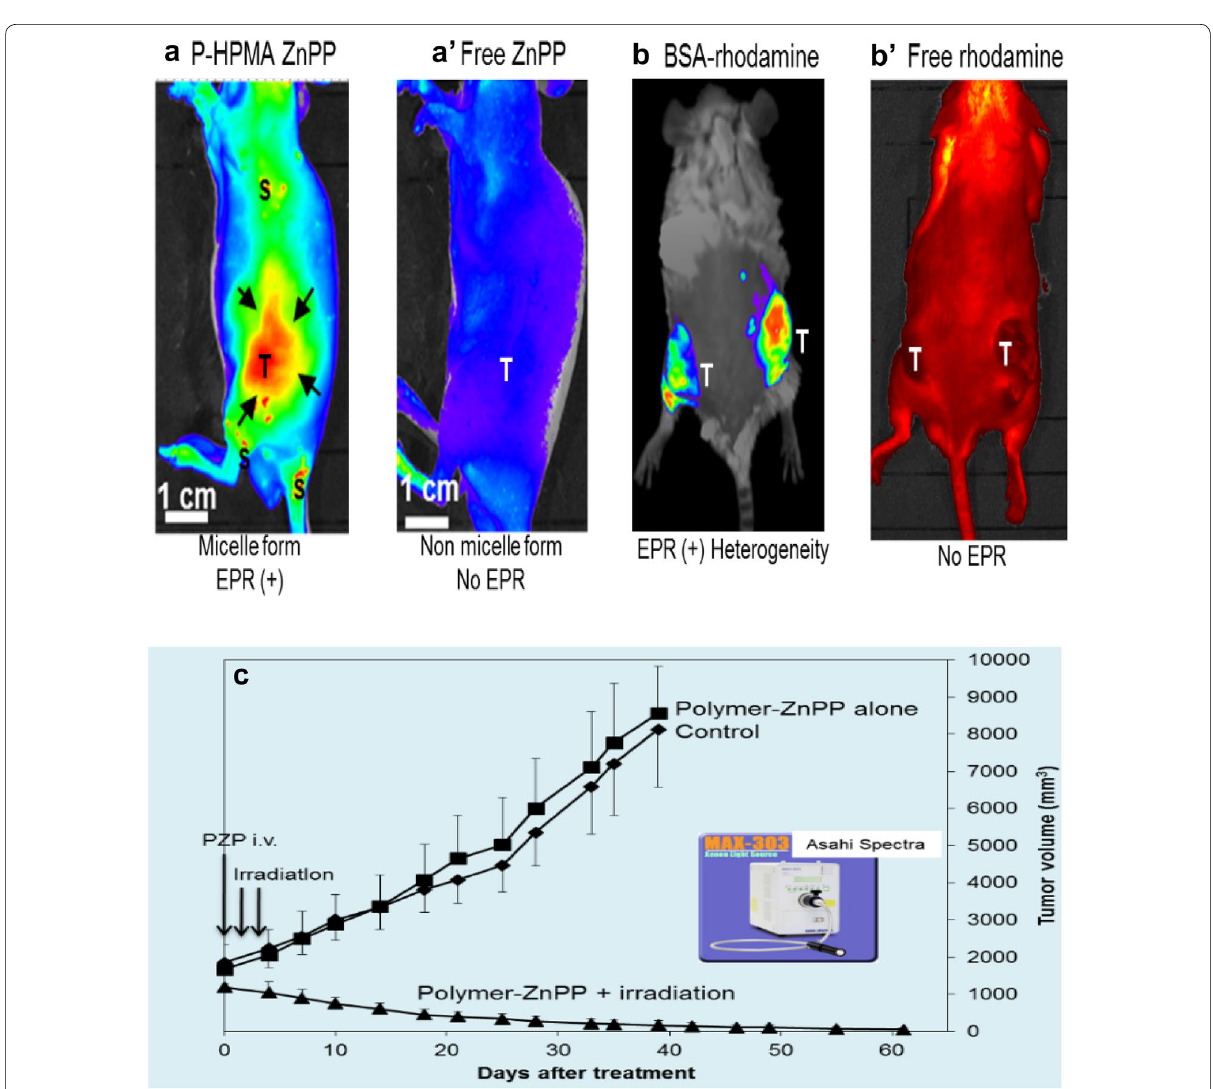
Fig. 3 Superiority of macromolecular photosensitizer: a polymer (HPMA)-conjugated zinc protoporphyrin (ZnPP) and b bovine serum albumin (BSA)-conjugated rhodamine. Fluorescence shows as visible only in tumors ( a ) and ( b ) (T marks). However, when both low MW photosensitizer, free ZnPP ( a ʹ ), and free tetramethylrhodamine ( b ʹ ) in tumor-bearing mice are injected iv, no tumor selective fluorescence image was visible. Macromol- ecules, namely polymer-(HPMA) ZnPP and BSA-rhodamine with apparent MWs about 50–70 kDa, respectively, selectively accumulated in tumors, because of the EPR effect, as shown by in vivo fluorescent imaging system; Contrary to above, free ZnPP and free rhodamine, with MWs less than 1000 Da, showed little tumor uptake ( a ʹ , b ʹ ). c Demonstrates therapeutic effect of PDT - treatment using polymeric ZnPP and endoscopic xenon light irradiation. Tumors used were chemically (diaminobenzene[α]anthracene) induced breast cancer in rats. Polymer-ZnPP alone or light irradiation alone respectively has no therapeutic effect [99, 122] (Figures were adapted from Refs. [99, 122] with